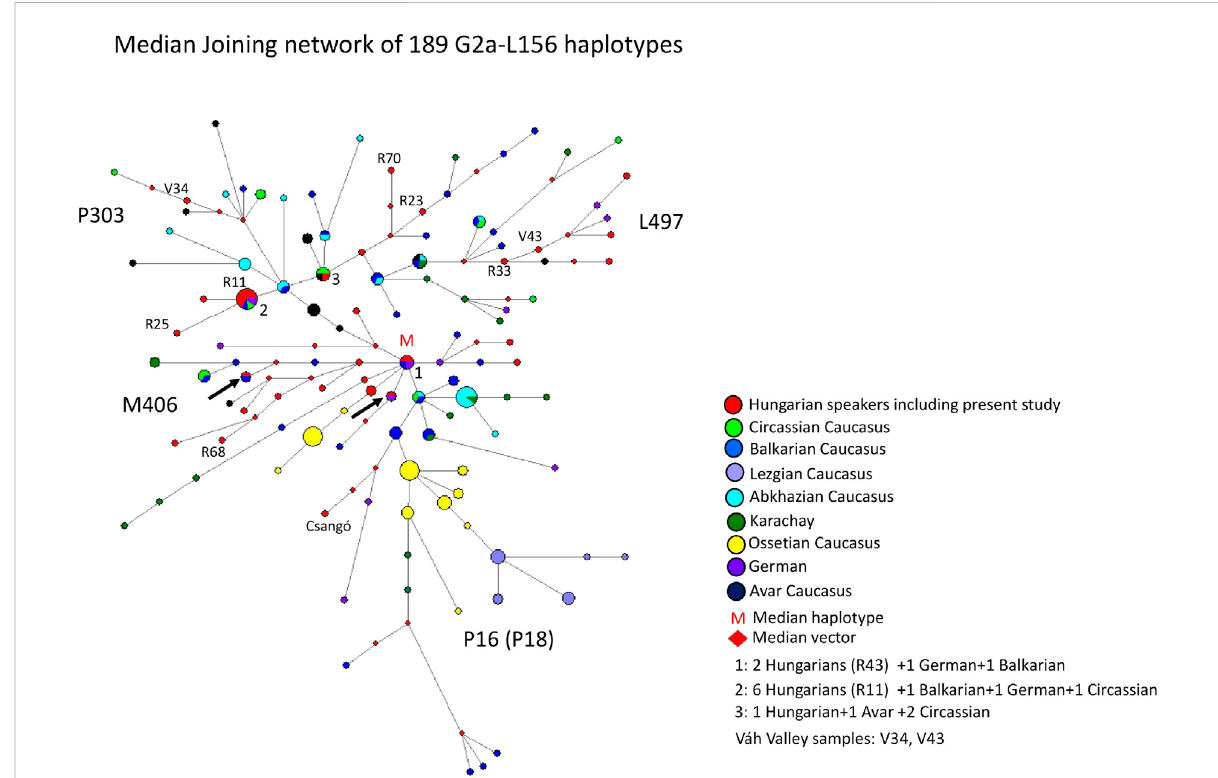
FIGURE 6 The Median-Joining Networks (MJ) of 189 G2a-L156 haplotypes. The circle sizes are proportional to the haplotype frequencies. The smallest area is equivalent to one